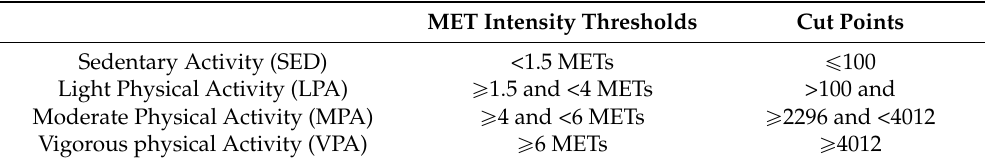
Table 1. MET Intensity Threshold and Cut